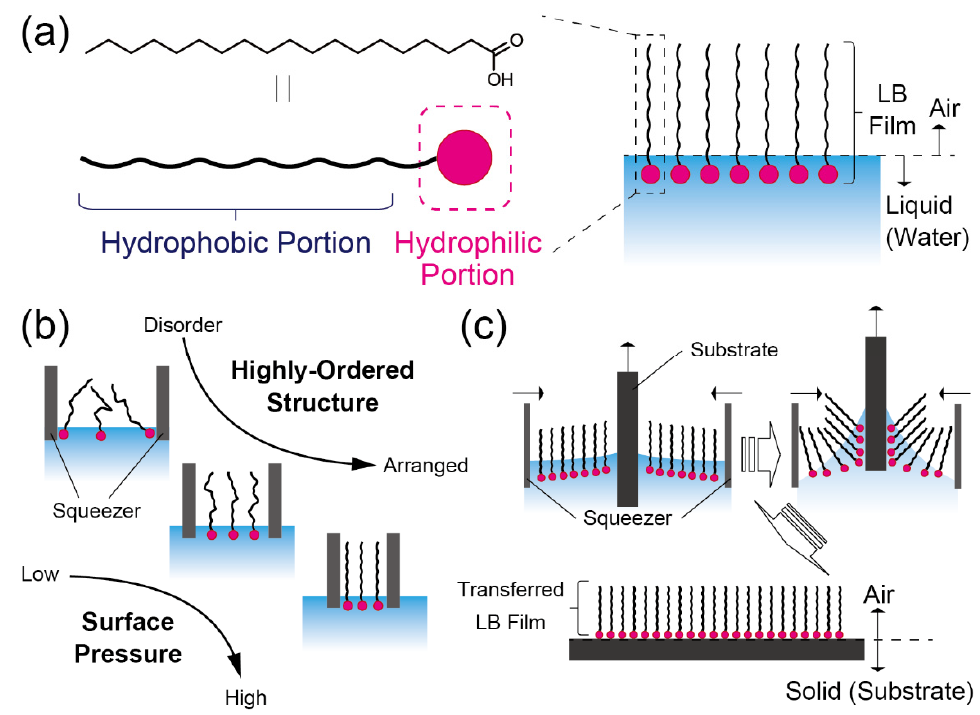
Figure 2. ( a ) Schematic illustration of a component material for the preparation of an LB film. A chemical structure indicates the typical molecule of the component (stearic acid). ( b ) The different phases of the LB films at each surface pressure. ( c ) The transfer procedure of the LB film from water to the substrate surface.